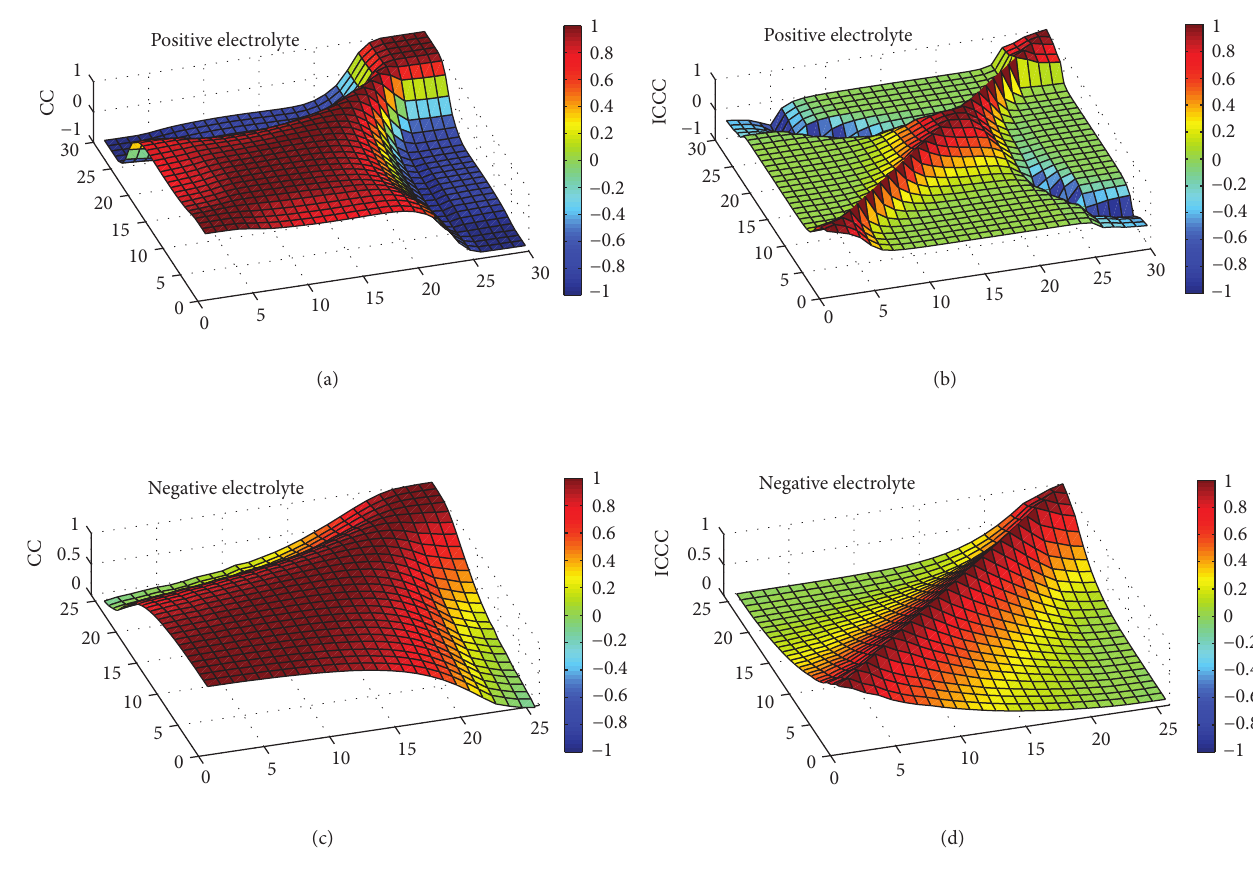
F 7: (a) e correlation coefficients (CCs) of the spectra of the 30 measurements for the positive electrolyte in Figure 3; (b) the intensity- corrected correlation coefficients (ICCCs) of the spectra of the 30 measurements for the positive electrolyte in Figure 3; (c) the correlation coefficients (CCs) of the spectra of the 26 measurements for the negative electrolyte in Figure 5; (d) the intensity-corrected correlation coefficients (ICCCs) of the spectra of the 26 measurements for the negative electrolyte in Figure